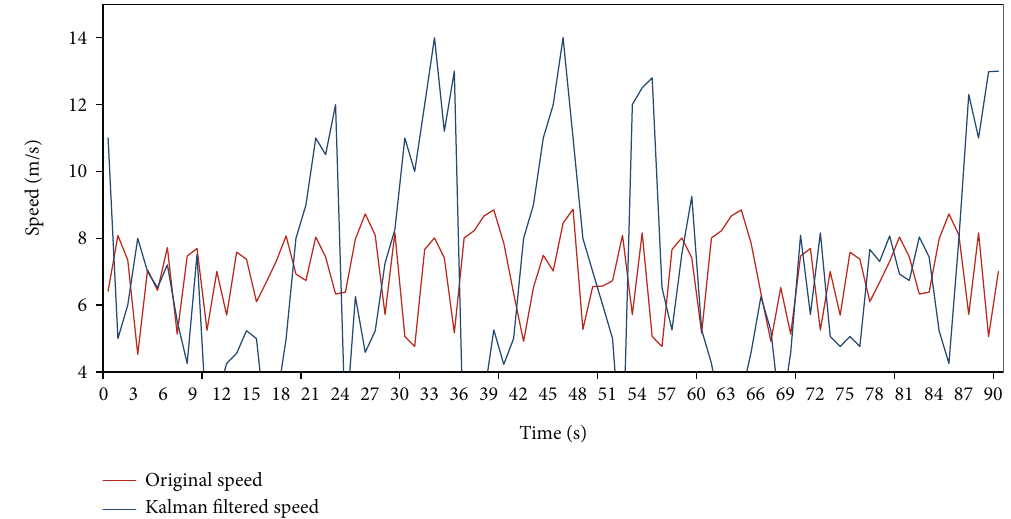
Figure 6: The Kalman fi lter e ff ect of introducing the time series model ARIMA